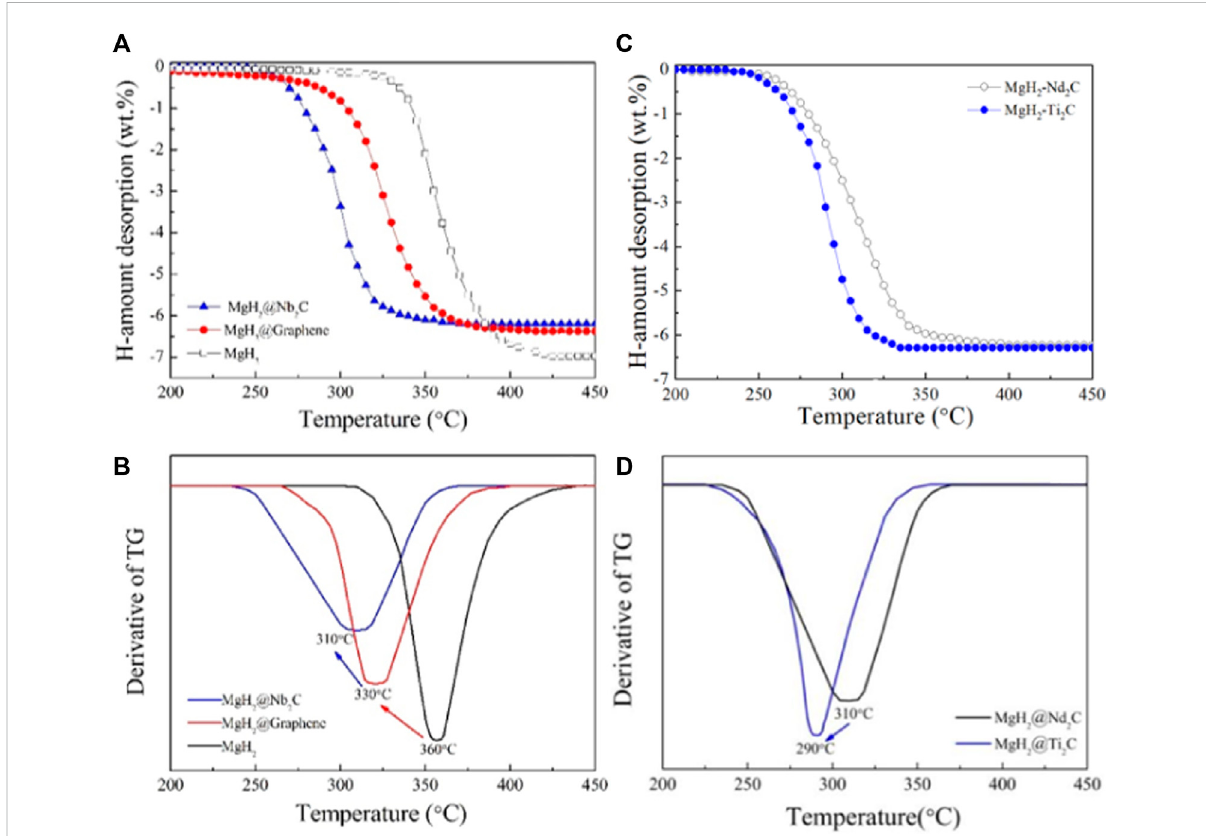
FIGURE 4 (A) Thetemperature — programmeddesorptioncurvesfortheMgH 2 @Nb 2 C (B) corresponding fi rstorderderivativegraph, (C)